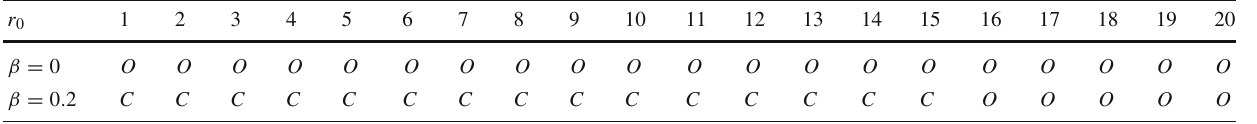
Table 1 The dynamics behaviors of the string with β = 0 and β = 0 .